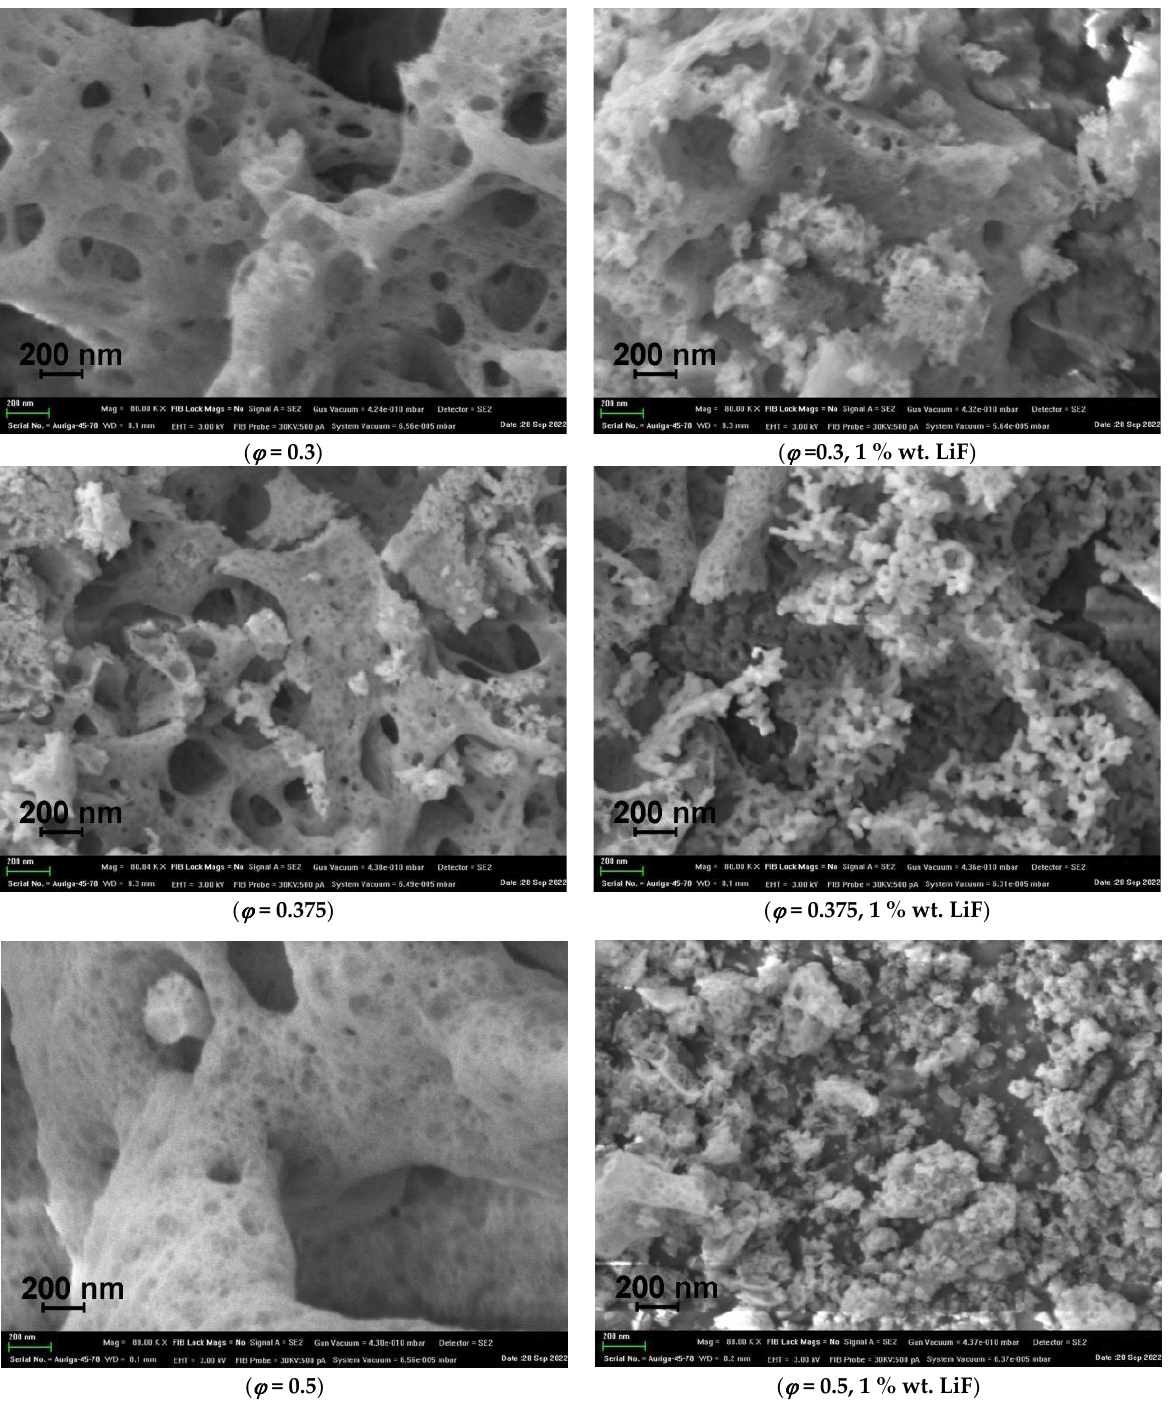
Figure 3. Micrographs of the Y 2 O 3 powders obtained by the SHS method from precursors with different compositions with and without LiF.